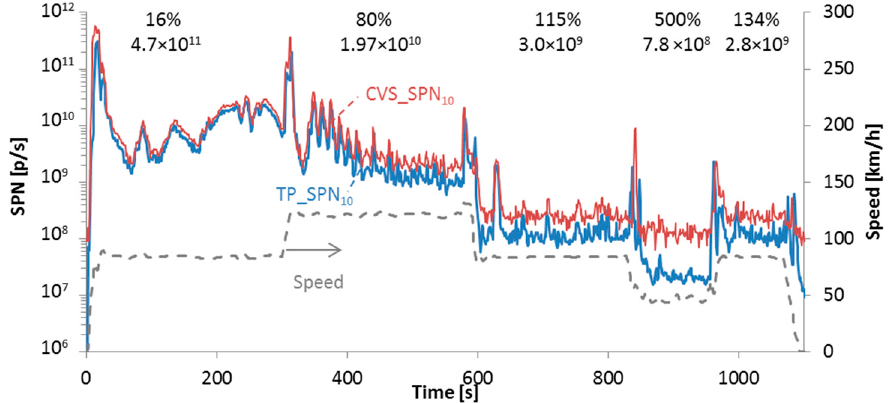
Figure 10. Solid particle number (SPN) emissions >10 nm measured at the tailpipe (TP) and the full dilution tunnel (CVS) for L3e-A3 #8. Speed and exhaust gas temperature is also shown. Numbers give SPN >10 nm emissions determined from the tailpipe instrument at the different speeds. Percentages give the differences of the dilution tunnel (CVS) instrument compared to the tailpipe one.